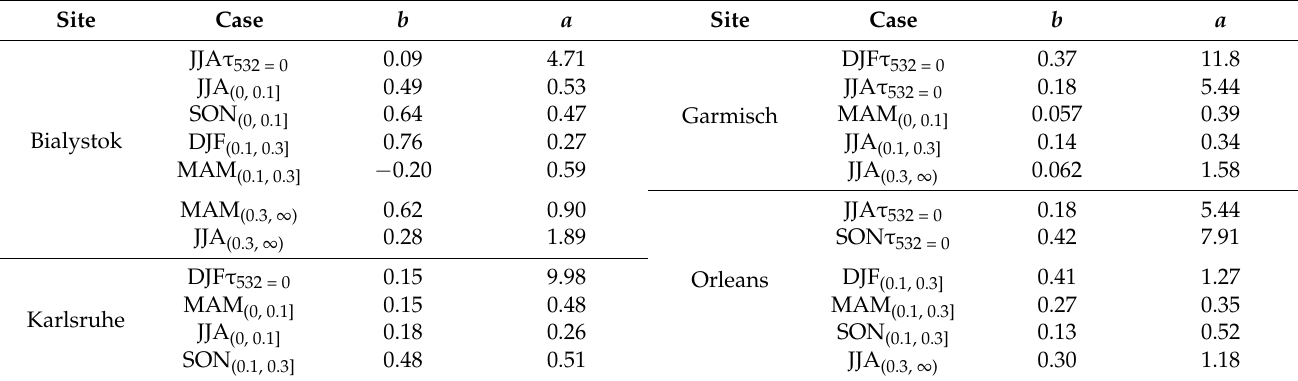
Table 6. Lookup table of linear regression equation coefficients of 22 cases.